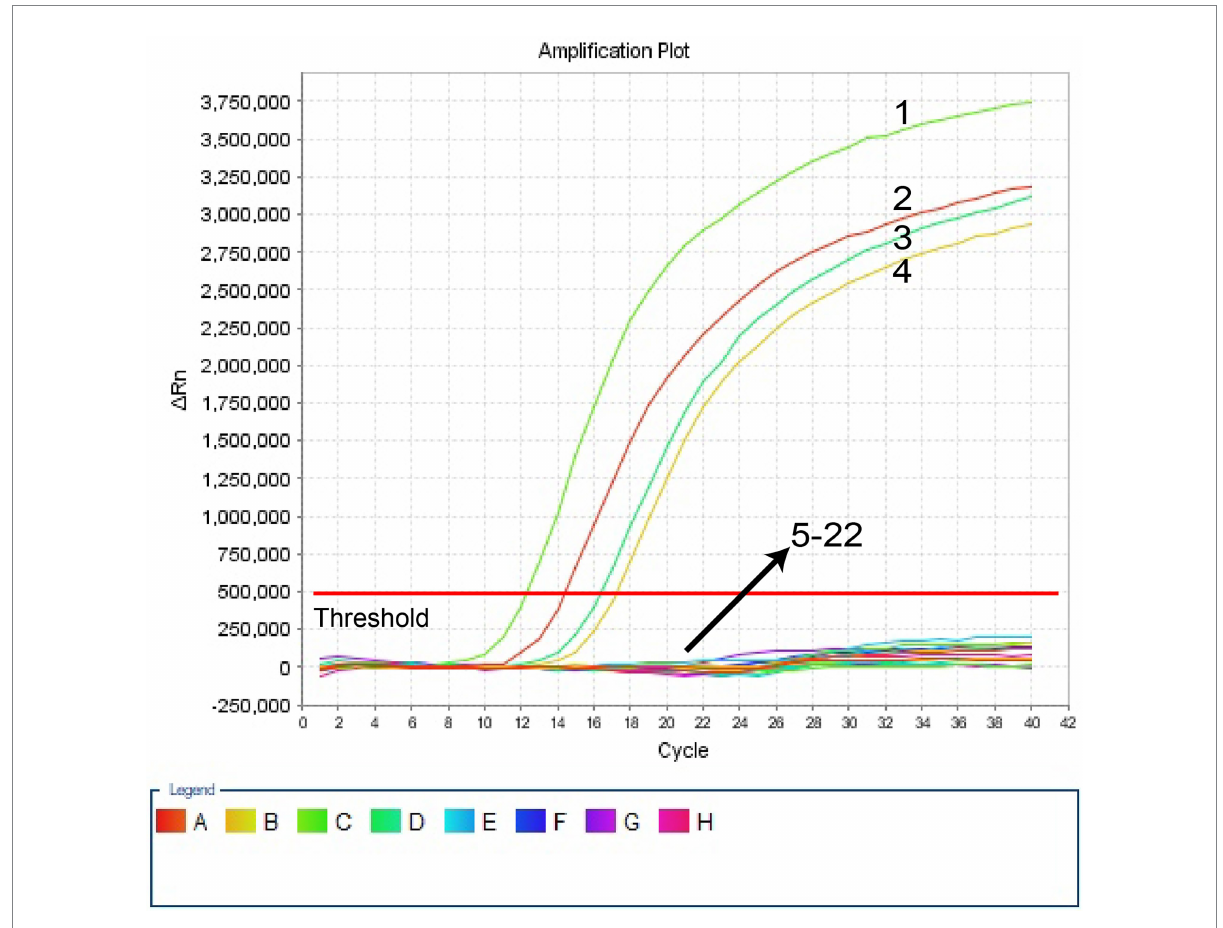
FIGURE 4 Specificity of H. influenzae- ERT-LAMP detection for different strains. The H. influenzae -ERT-LAMP amplifications were performed using different genomic DNA templates and were monitored by means of real-time detection. Signals 1, Positive control ( H. influenzae ATCC10211), signals 2–4,